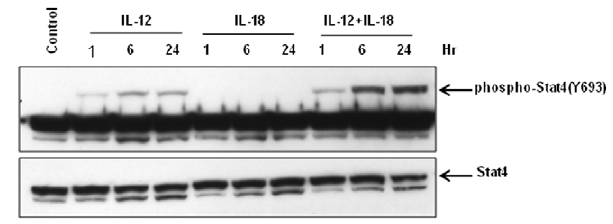
Figure 3. Synergistic effect of IL-12 plus IL-18 treatment on Stat4 phosphorylation. Human peripheral blood CD4 + T cells were treated with IL-12 and IL-18, either alone or in combination, for different periods of time. Equal amounts of whole cell lysates (35 m g) were analyzed by western blot analysis.